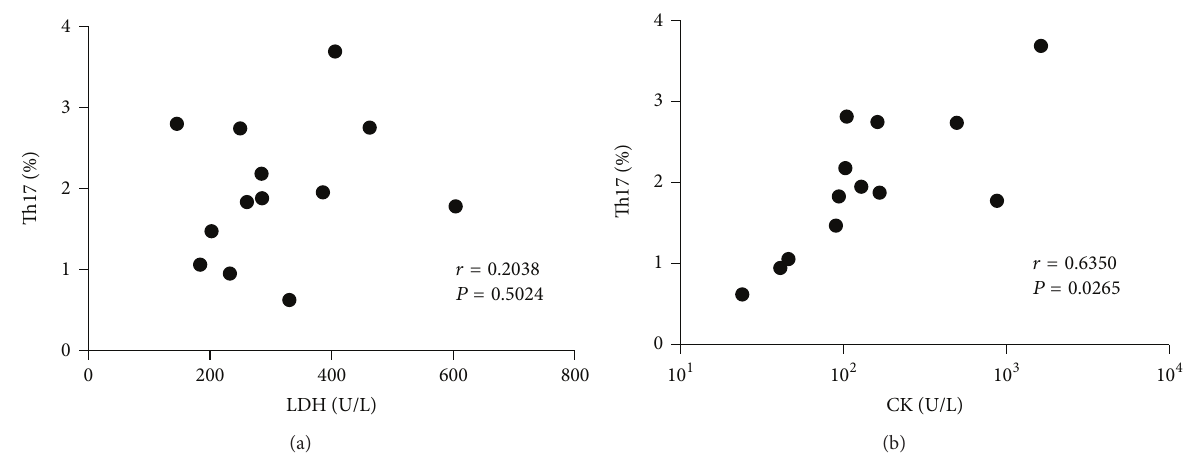
Figure 2: The correlation between the percentages of Th17 lymphocytes in PBMCs and LDH (left)/CK (right) in DM patients.